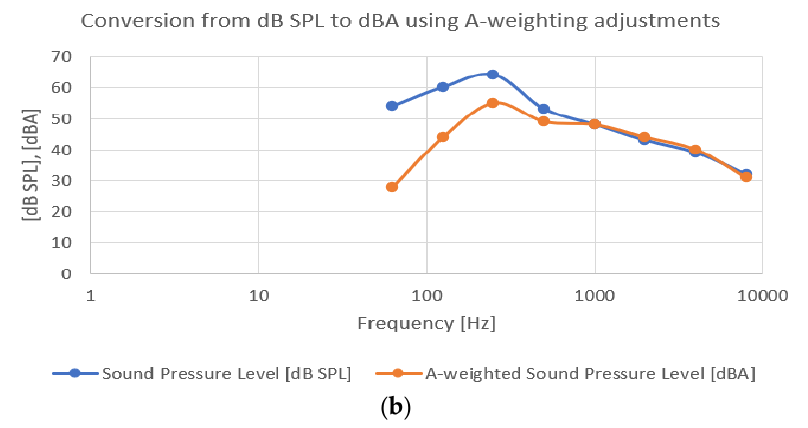
Figure 1. ( a ) The A-weighted curve for sound data compensation; ( b ) conversion from dB SPL to dBA using A-weighting adjustments.